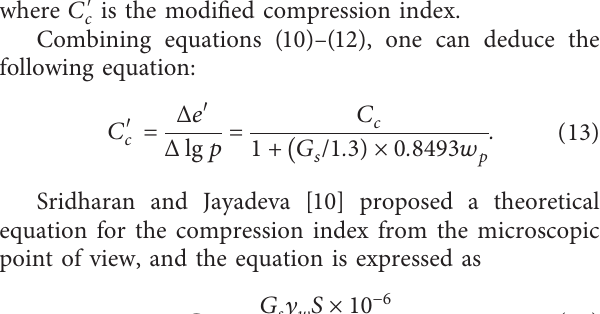
Figure 11: Comparison of conventional, theoretical, and modified compression indexes of different soils. Note: C c is the conventional compression index; C ct is the theoretical compression index; C c ′ is the modified compression